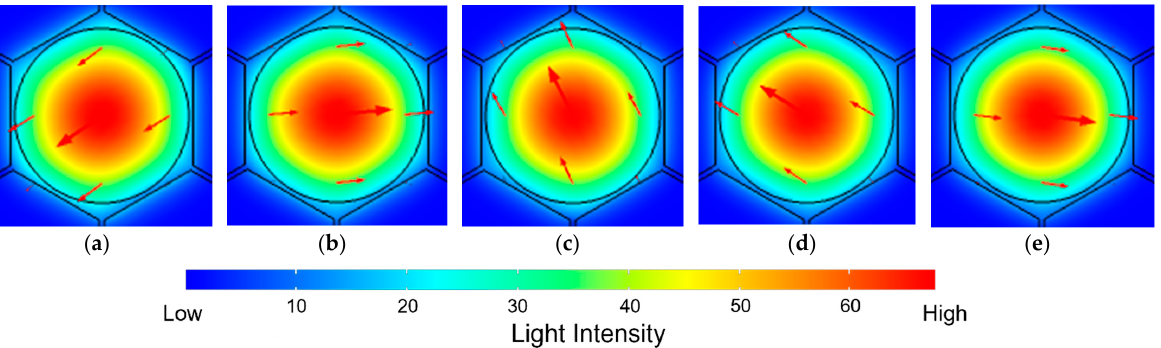
Figure 2. Mode profile of the proposed PCF at 1.1 µm with sulfuric acid concentrations of ( a ) 0% ( b ) 10% ( c ) 20% ( d ) 30% ( e ) 40%.